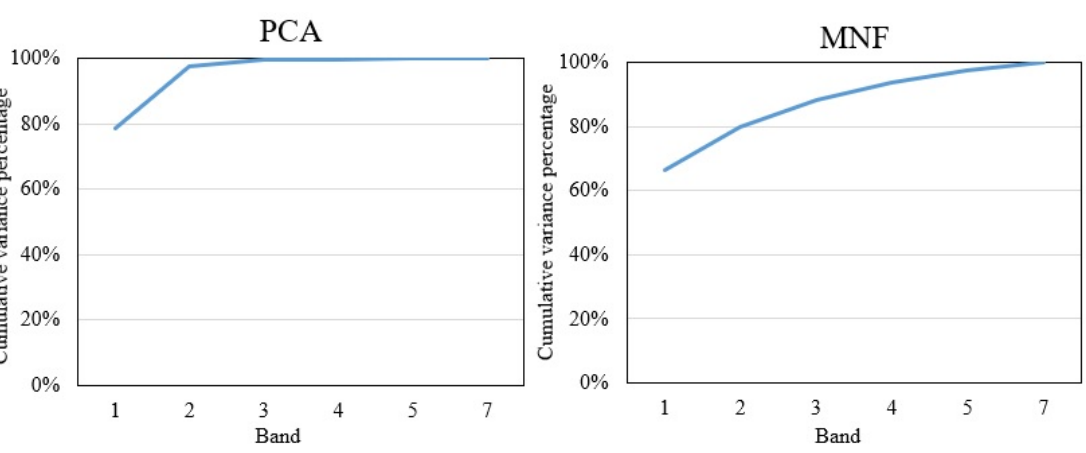
Figure 3. Cumulative variance percentage of the principal component analysis (PCA) and minimum noise fraction rotation (MNF).